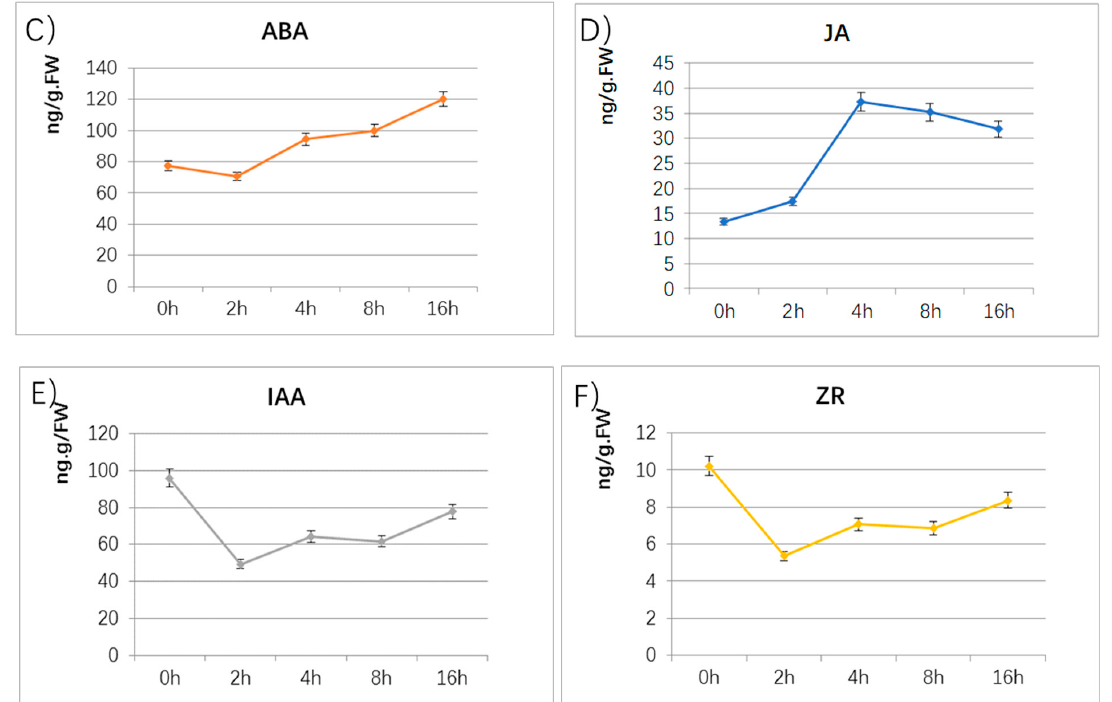
Figure 2. Changes of endogenous phytohormones contents during exogenous GA 3 treatment. ( A ) Comparison of the contents of five endogenous phytohormones during exogenous GA 3 treatment. ( B ) Changes of gibberellins contents during exogenous GA 3 treatment. ( C ) Changes of ABA contents during exogenous GA 3 treatment. ( D ) Changes of JA contents during exogenous GA 3 treatment. ( E ) Changes of IAA content during exogenous GA 3 treatment. ( F ) Changes of ZR content during exogenous GA 3